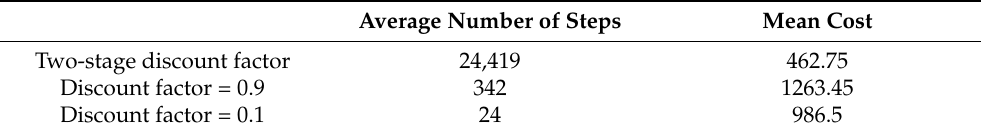
Table 5. Test results for the average number of steps and mean cost for the two-stage discount factor, discount factor = 0.9, and discount factor =